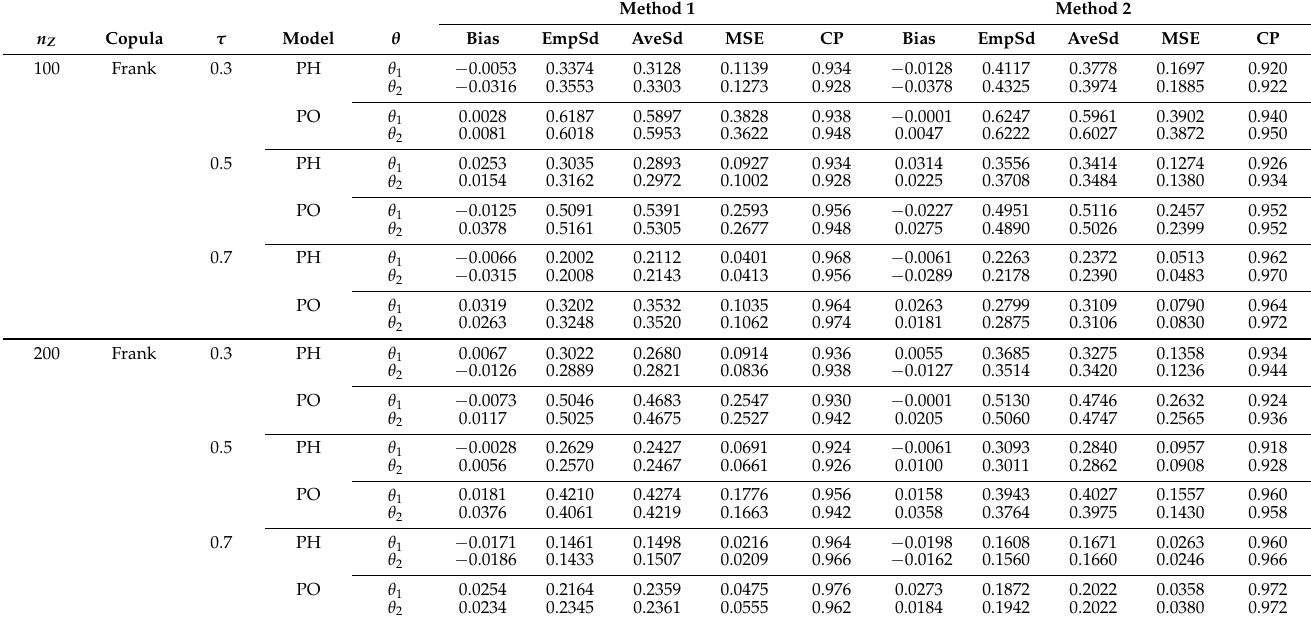
Table 4. The estimators of θ under Case 2 when the variable of interest is Y.